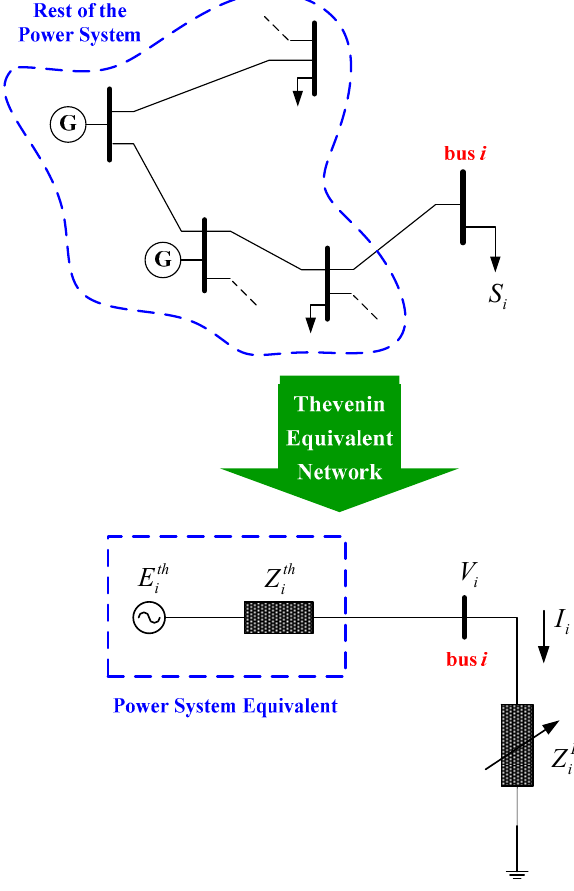
Figure 2. Thevenin equivalent (TE) network for a power system seen at a load bus.